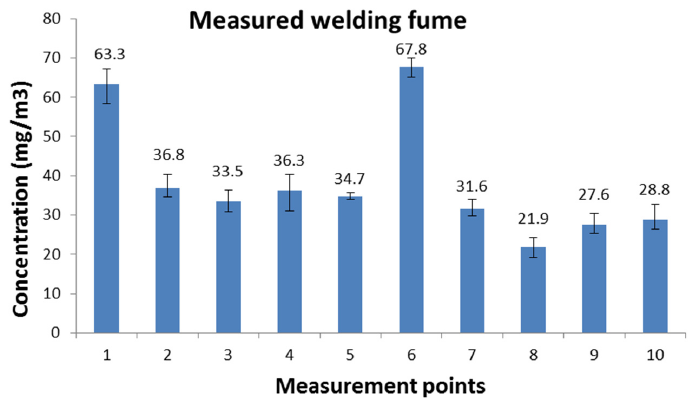
Figure 6. Concentration of measured welding fume at ten measurement points.